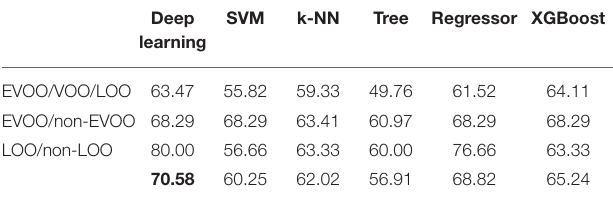
TABLE 4 | Sensitivity comparison with other methods for 2014–2016 (D1-D2) harvests.